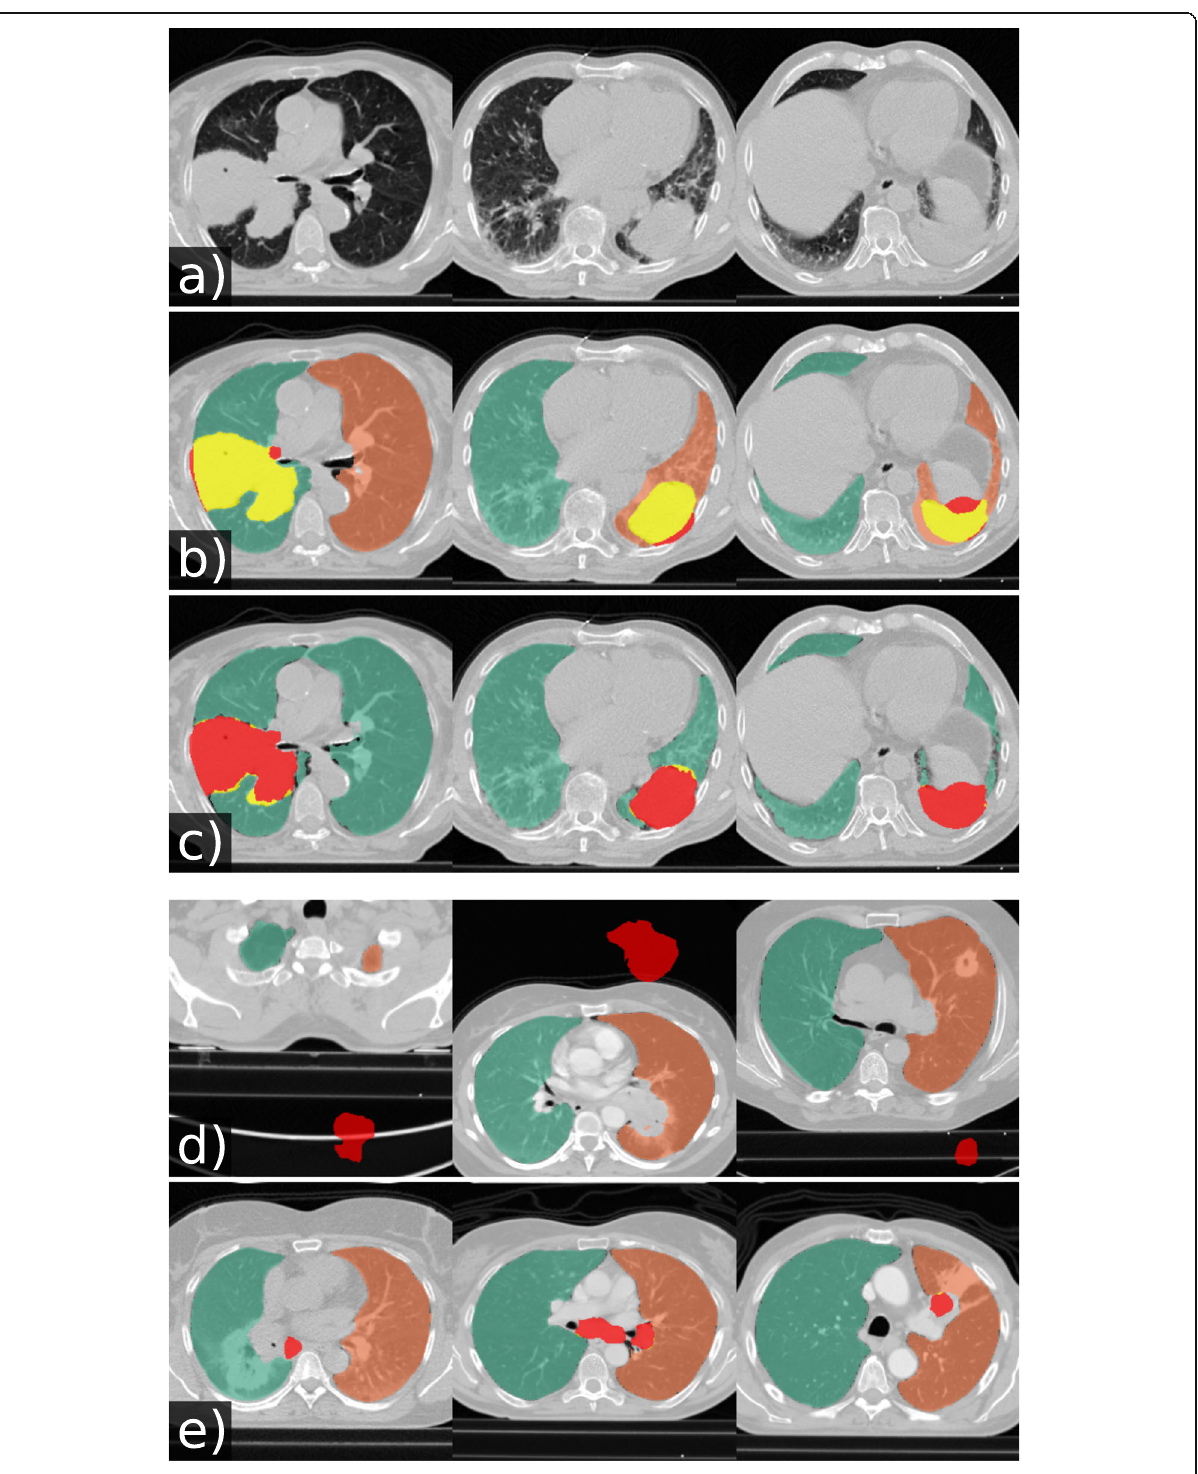
Fig. 5 Qualitative results of automatically generated lung masks for tumour cases. Yellow: tumour area covered by the lung mask. Red: tumour area not covered by the lung mask. Original images ( a ), lung masks generated by our U-net(R-231) ( b ), lung masks generated by P-HNN ( c ), corrupted tumour segmentations in the Lung1 dataset ( d ), and cases with poor tumour overlap of lung masks generated by U-net(R-231) ( e